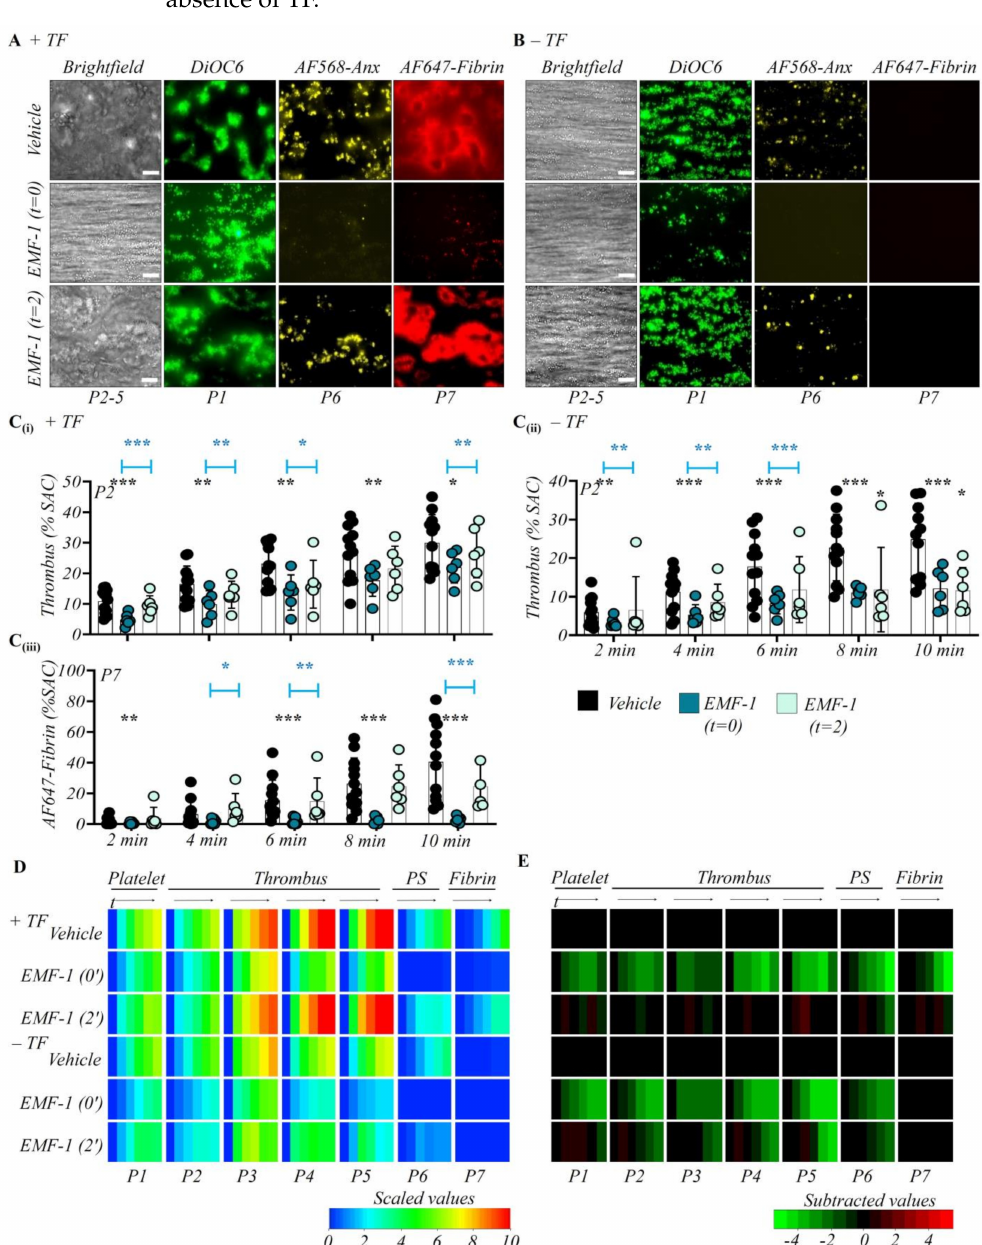
Figure 3. Time-dependent contribution GPVI in thrombus formation. Citrated whole blood was labeled and co-perfused with recalcification medium over collagen and collagen/TF microspots ( n = 6). Where indicated, perfusion was switched from control blood to blood preincubated with vehicle or anti-GPVI Fab EMF-1 (10 µ g/mL, f.c.). Thrombus parameter analysis and heatmap presentation were as for Figure 1. ( A , B ) Representative end stage images of vehicle control condition; early GPVI inhibition (EMF-1 Fab from start); later GPVI inhibition (EMF-1 Fab from 2 min). Images from microspots without ( A ) or with ( B ) TF; bars = 20 µ m. Quantitative analysis from ± TF surfaces of parameter P2: thrombus coverage ( Ci , Cii ), and P7: fibrin deposition ( Ciii ). Means ± SD, * p < 0.05, ** p < 0.01, *** p < 0.001 vs. indicated group ( t -test). ( D ) Heatmap of univariate scaled time-dependent values, and ( E ) subtracted heatmap of scaled parameters versus control runs, as for Figure 1. For additional data, see Figure